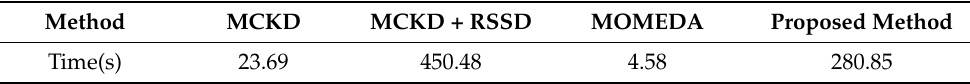
Table 5. Comparison of the average running time of different